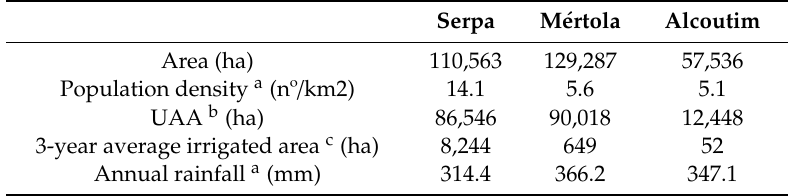
Table 1. Summary information on the characteristics of the three municipalities of the case study.